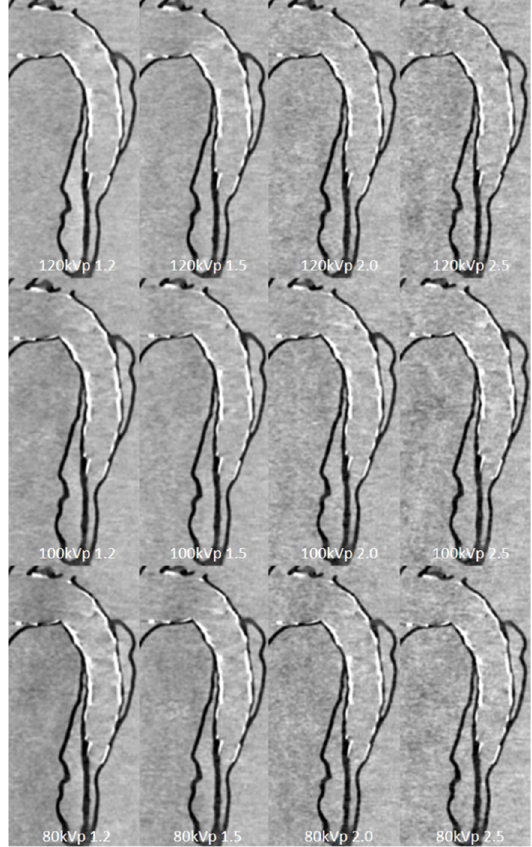
Figure 14. Sagittal reformatted images of the CTA protocols. When kVp decreased to 80, image noise increased with the use of high-pitch value protocols such as 2.0 and 2.5. Reprinted with permission under the open access from Wu et al. [25].